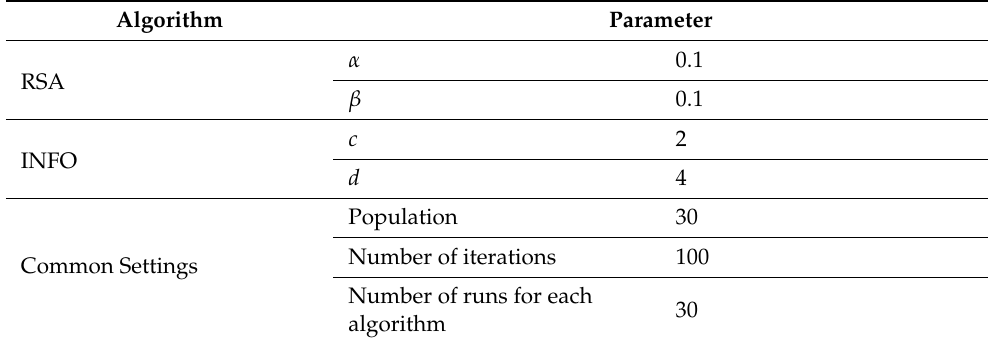
Table 3. Parameter settings for all